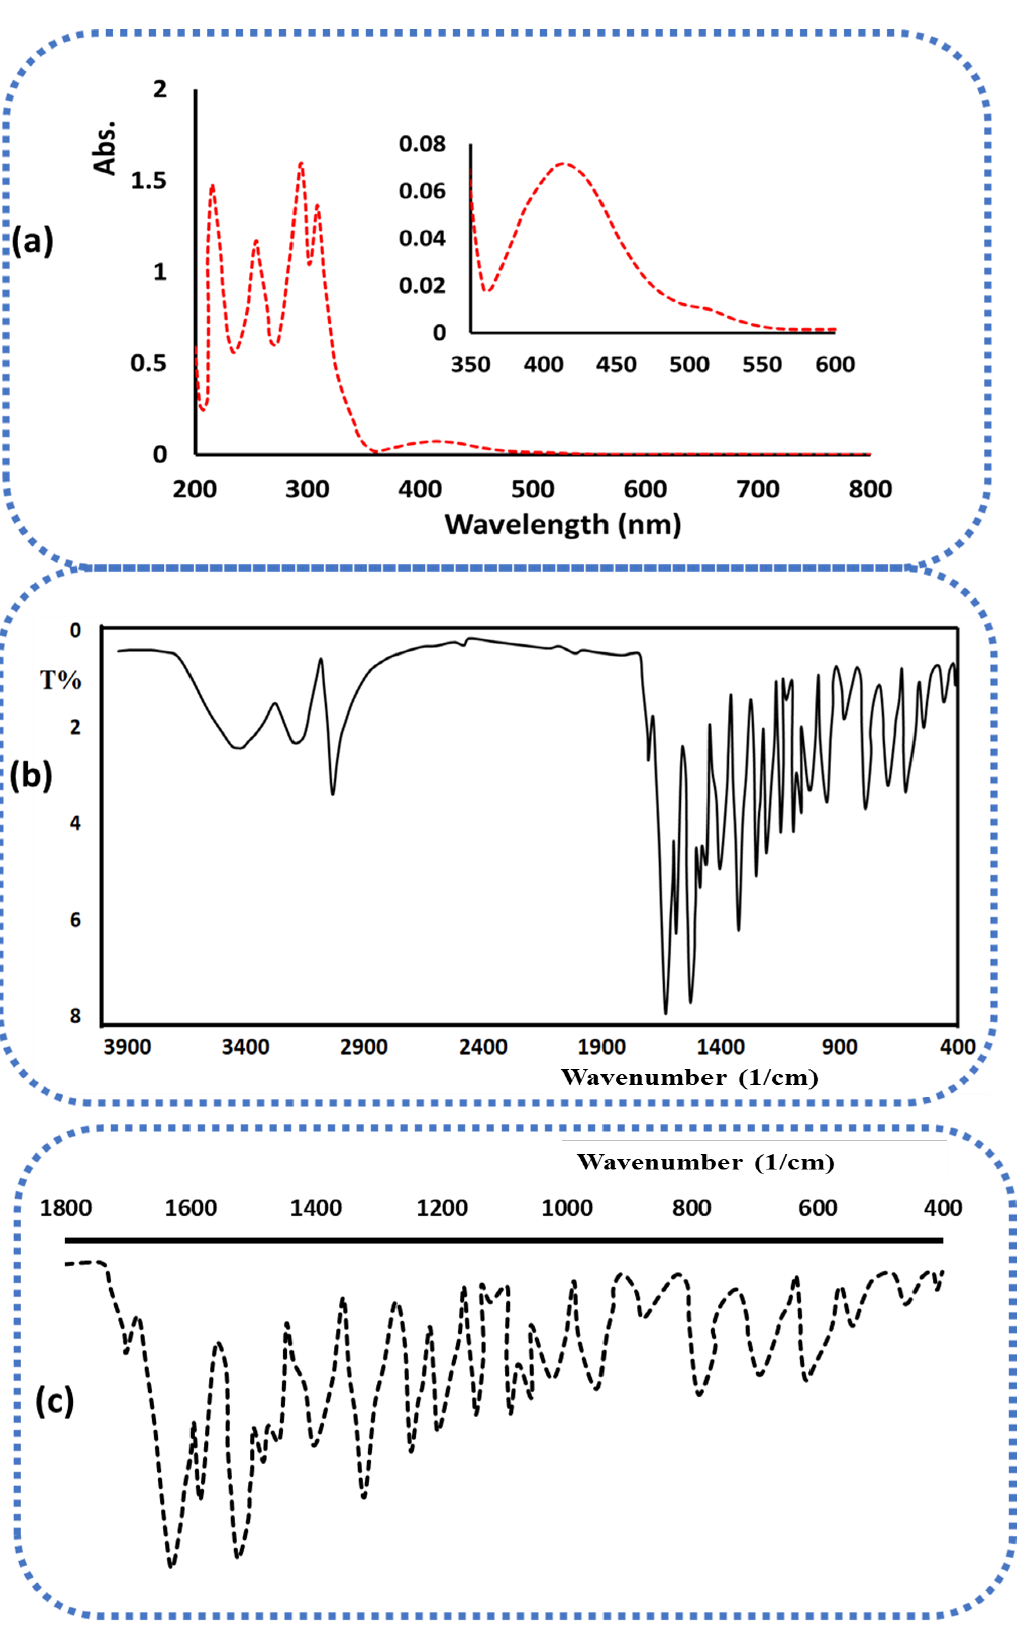
− 1 scale FT-IR of {[NiLCl(H 2 O) 2 ][NiL(H 2 O) 3 ]}3Cl.5H 2